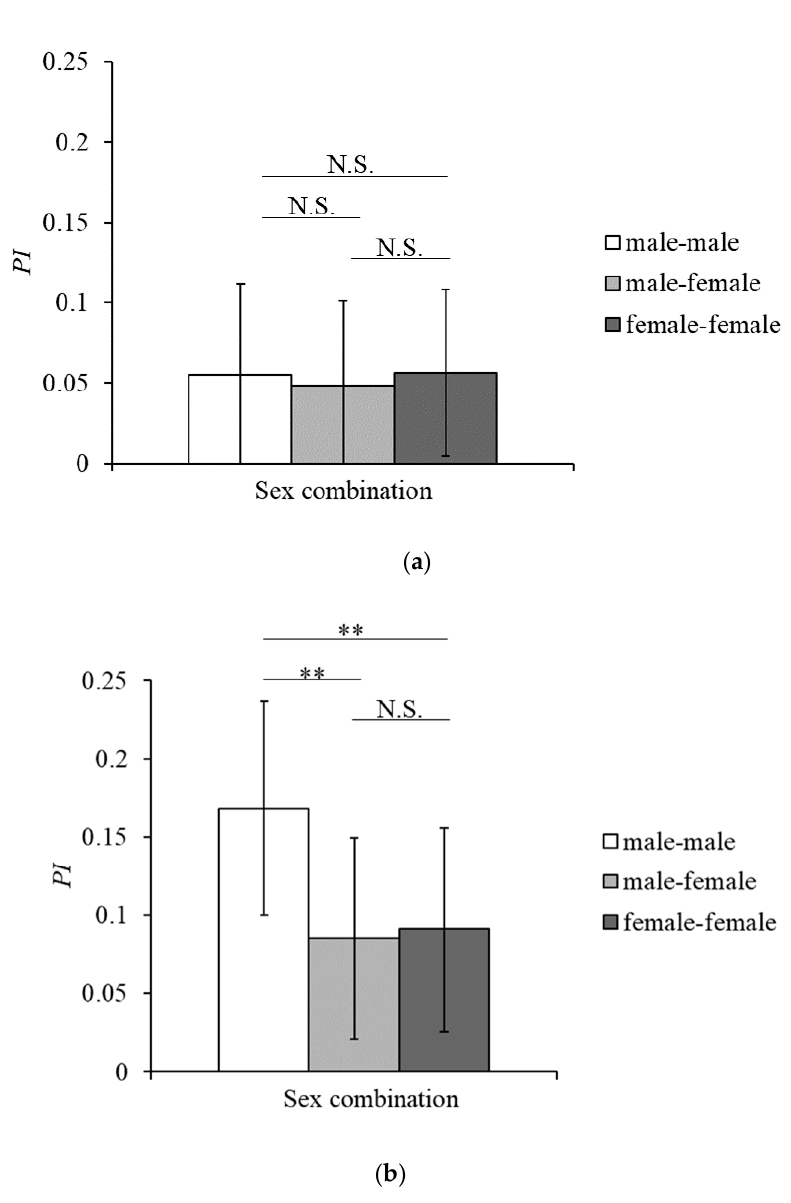
Figure 3. Proximity indexes ( PI s) of each sex combination of focal individuals in Tama ( a ) and Mahale ( b ). Error bars indicate standard deviation. ** denotes a significance of p < 0.01, and N.S. denotes a nonsignificant ( p > 0.05).